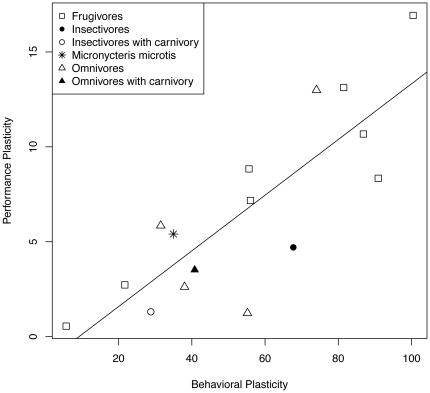
Behavioral and performance plasticity in phyllostomid bats while feeding on soft and hard prey items (fruits or insects).Species included for comparison are frugivores: Artibeus jamaicensis, Artibeus phaeotis, Carollia perspicillata, Centurio senex, Platyrrhinus helleri, Sphaeronycteris toxophyllum, Sturnira lilium and Uroderma bilobatum; insectivore: Mimon crenulatum; insectivore with carnivory (animalivory): Tonatia saurophila; omnivores: Carollia brevicauda, Glossophaga soricina, Phylloderma stenops, Phyllostomus discolor; omnivore with carnivory: Phyllostomus hastatus. (R2  =  0.684, F1,14  =  9.3679, P  =  7.738exp-05).